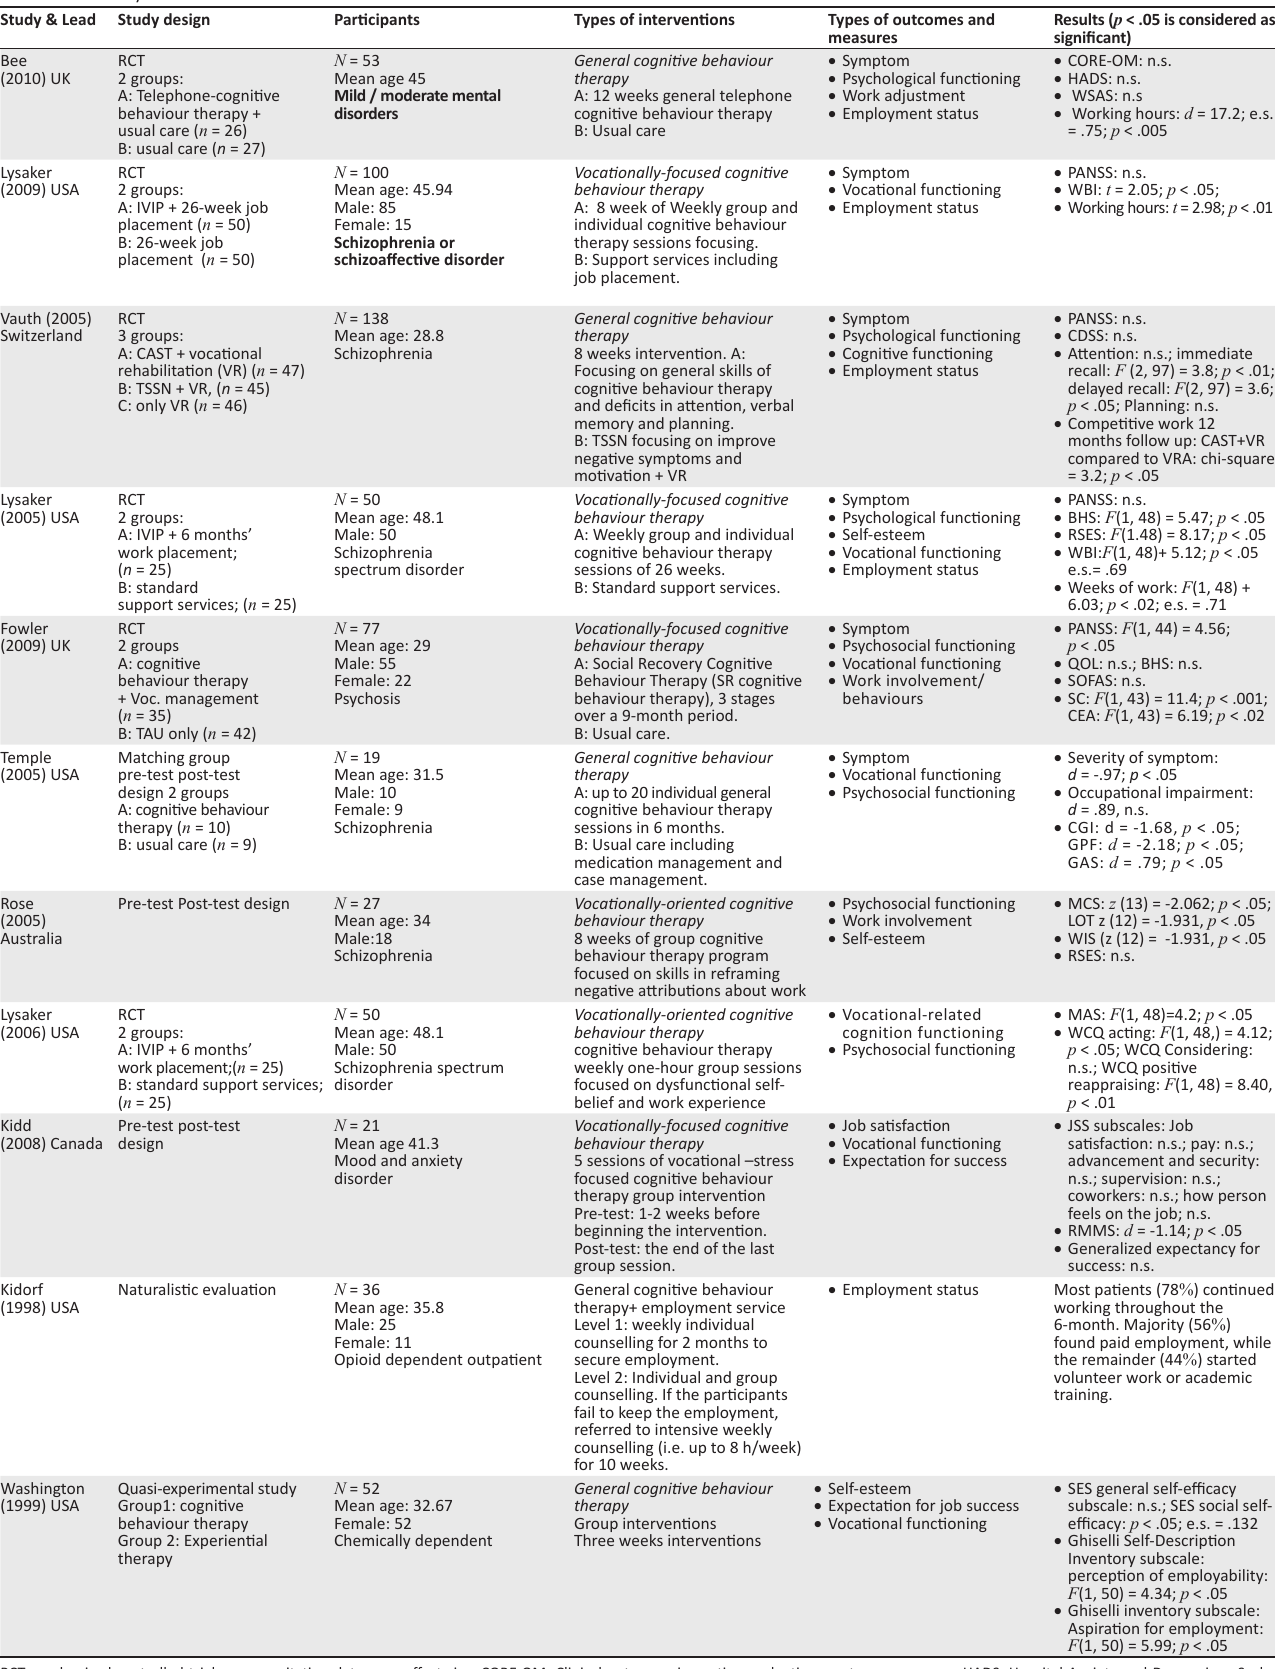
TABLE 1: Summary of studies included in this